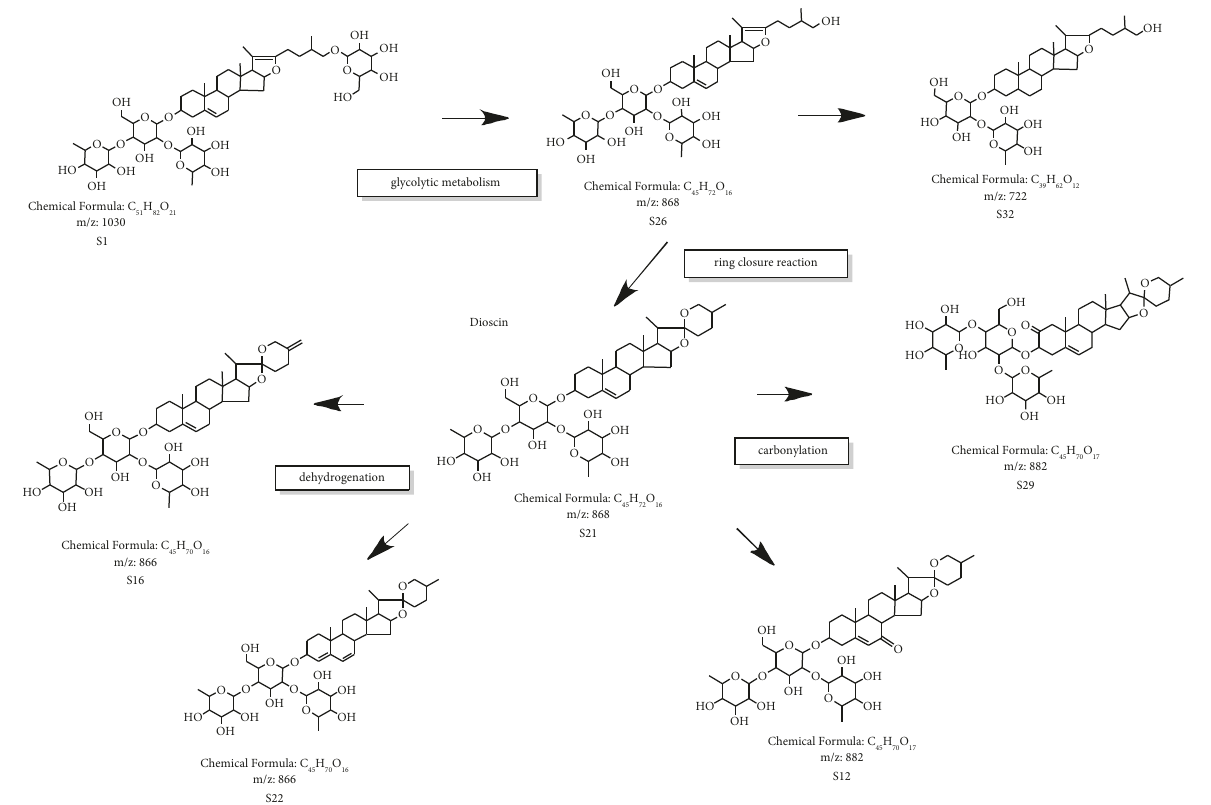
Figure 7: Various conversion